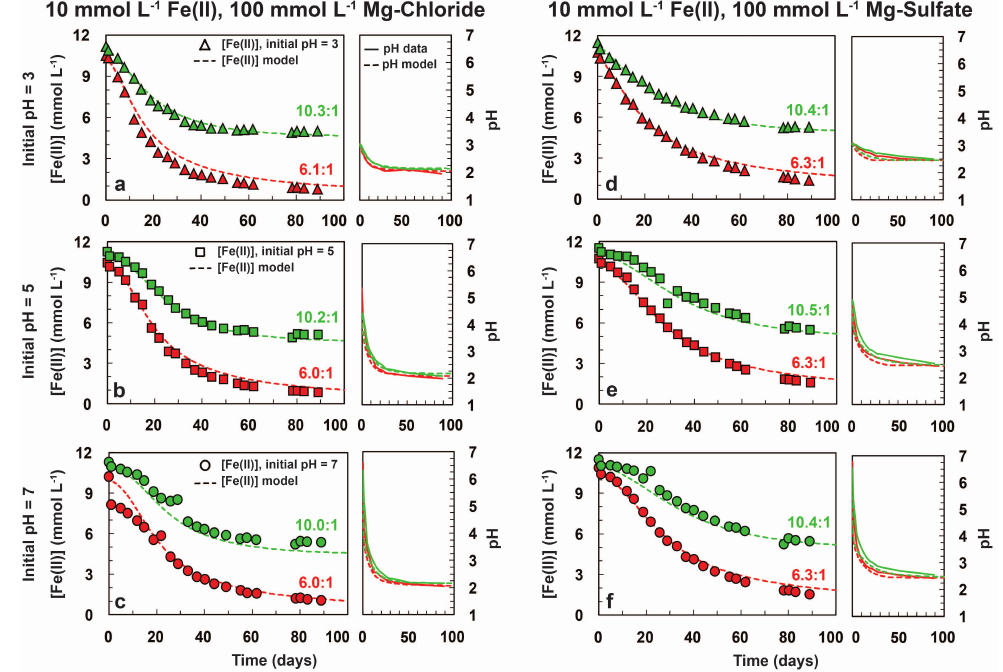
Figure 1. The dissolved Fe(II) concentration and pH versus time in systems containing approximately 10 mmol L − 1 Fe(II) with 1.67 ([Fe(II)] / [ClO 3 − ] ≈ 6) mmol L − 1 and 1 mmol L − 1 ( ≈ 10) ClO 3 − in 10 − 1 mol L − 1 MgCl 2 at initial ( a ) pH 3, ( b ) pH 5, and ( c ) pH 7, and in 10 − 1 mol L − 1 MgSO 4 fluids at initial ( d ) pH 3, ( e ) pH 5, and ( f ) pH 7 at 24 ◦ C. The ratios written alongside the curves represent the initial molar ratio between [Fe(II)] and [ClO 3 −